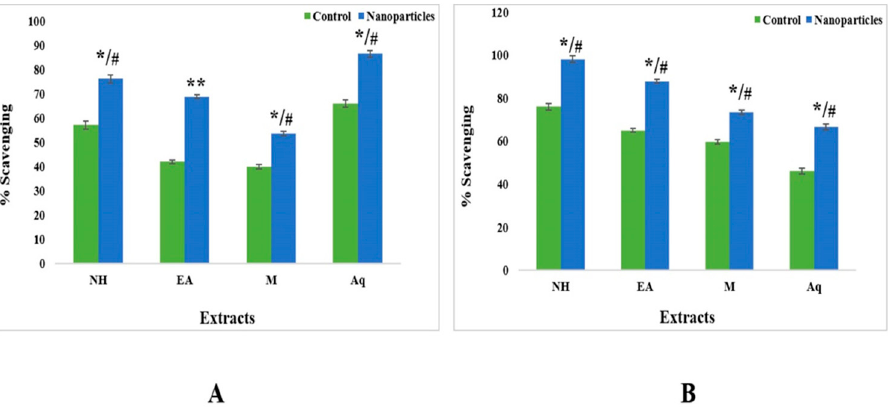
Figure 10. Comparative analysis of control and zinc oxide nanoparticles from ( A ) leaf and ( B ) fruit extracts of C. colocynthis . Mean ± SD is expressed as */# p < 0.05, ** p < 0.01.